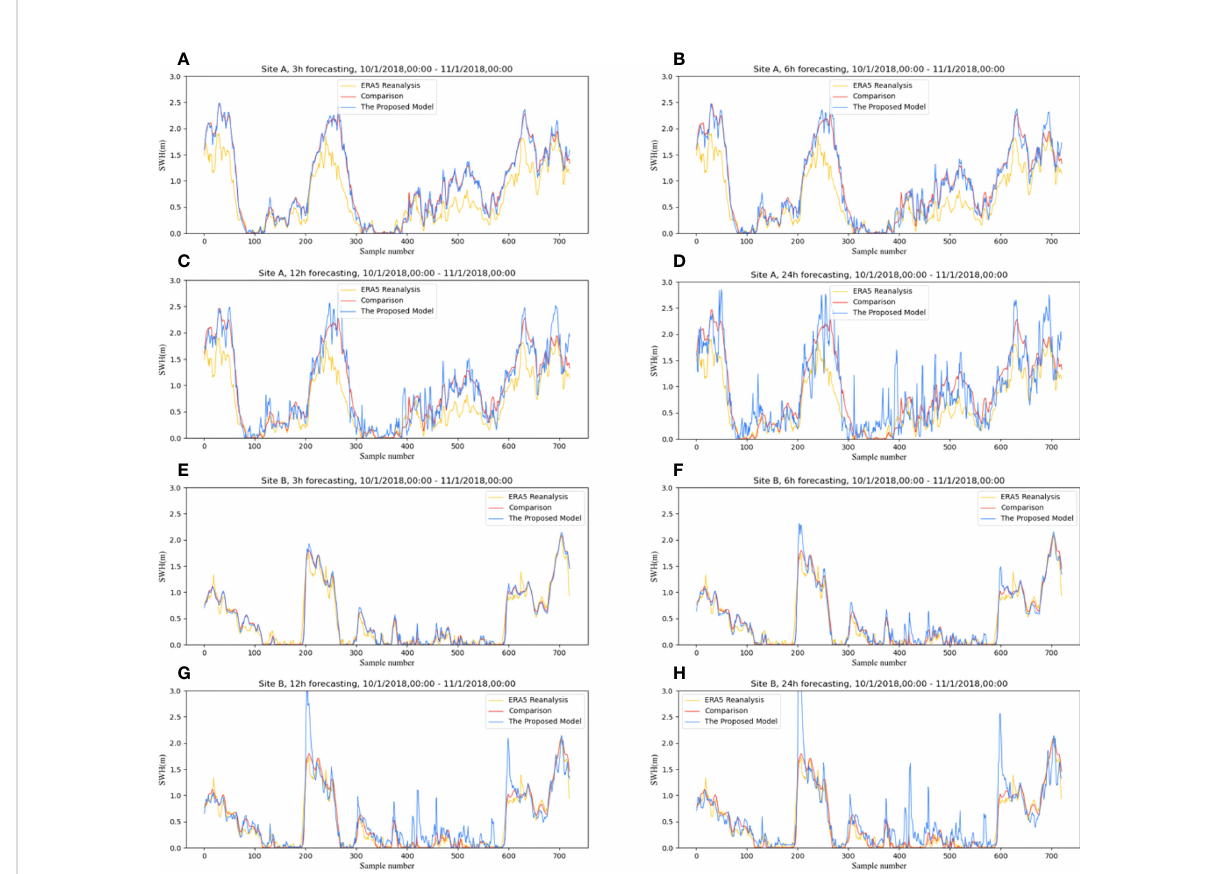
FIGURE 15 24-hour prediction results of signi fi cant wave heights for SiteA and SiteB. (A – D) respectively represent the 3h, 6h, 12h and 24h forecast results of SiteA, and (E – H) respectively represent the 3h, 6h, 12h and 24h forecast results of